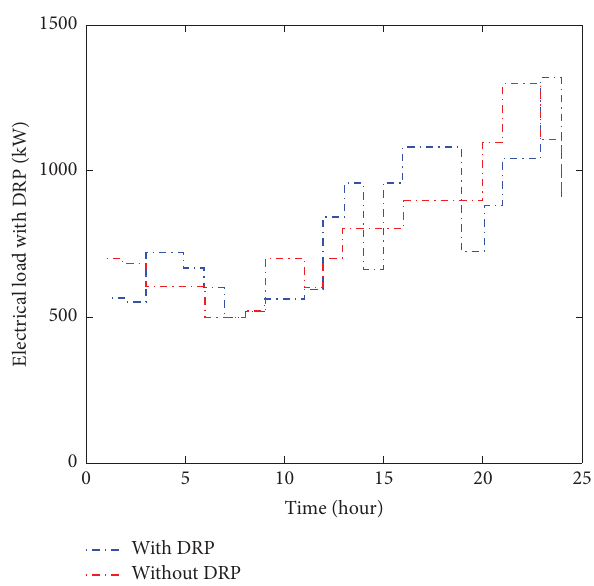
Figure 9: Electric load with/without DRP.